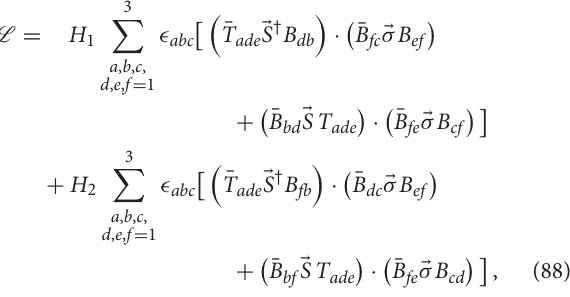
These operators fulfill the relation S i S j †